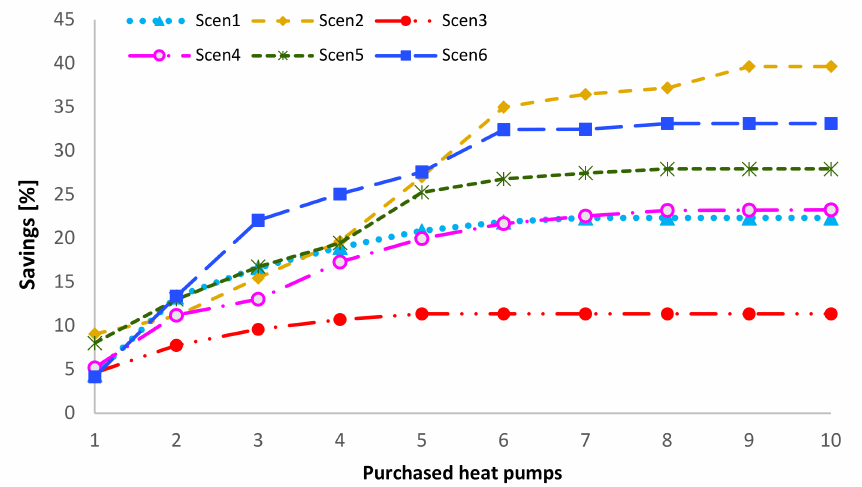
Figure 3. Savings percentage according to the purchased heat pumps for each